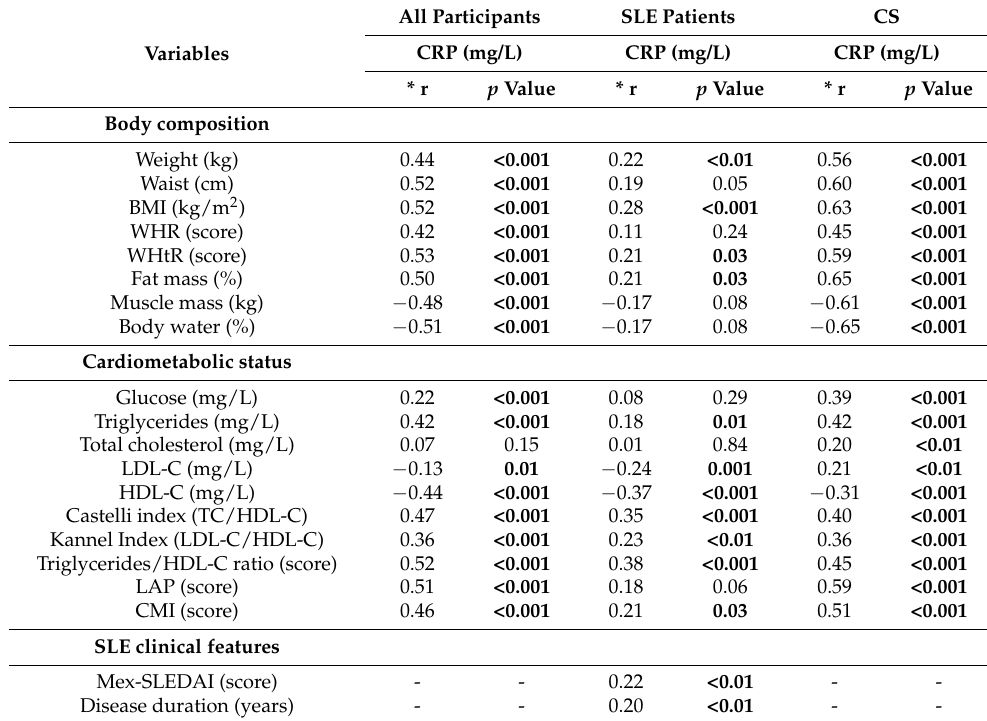
* Spearman correlation test. The bold numbers indicate variables with significant differences. SLE: systemic lupus erythematosus; CS: control subjects; CRP: C-reactive protein; BMI: body mass index; WHR: waist to hip ratio; WHtR : waist to height ratio (cm/cm); LDL-C: low-density lipoprotein cholesterol; HDL-C: high-density lipoprotein choles- terol; TC: total cholesterol; LAP: lipid accumulation products; LAP = (waist in cm − 58)*(triglycerides